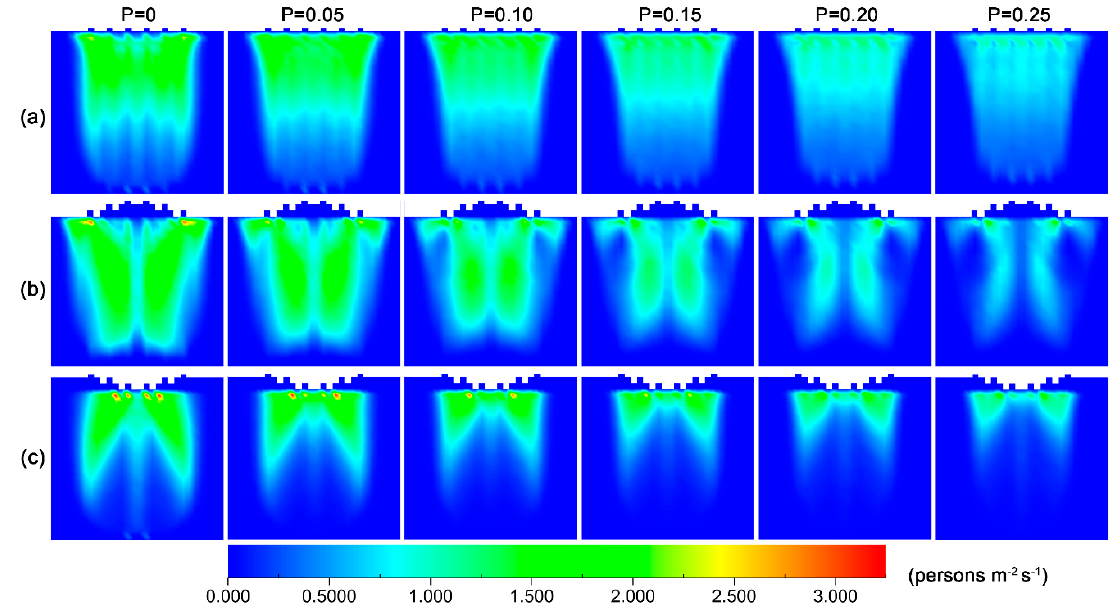
Figure 9. Distribution of competitive pedestrian-time at different checking failure probabilities for the three layouts of inspection points: ( a ) parallel, ( b ) convex and ( c ) concave. The checking failure probability and delay are 0.08 and 3 s, respectively. The unit of pedestrian density is persons/m 2 .